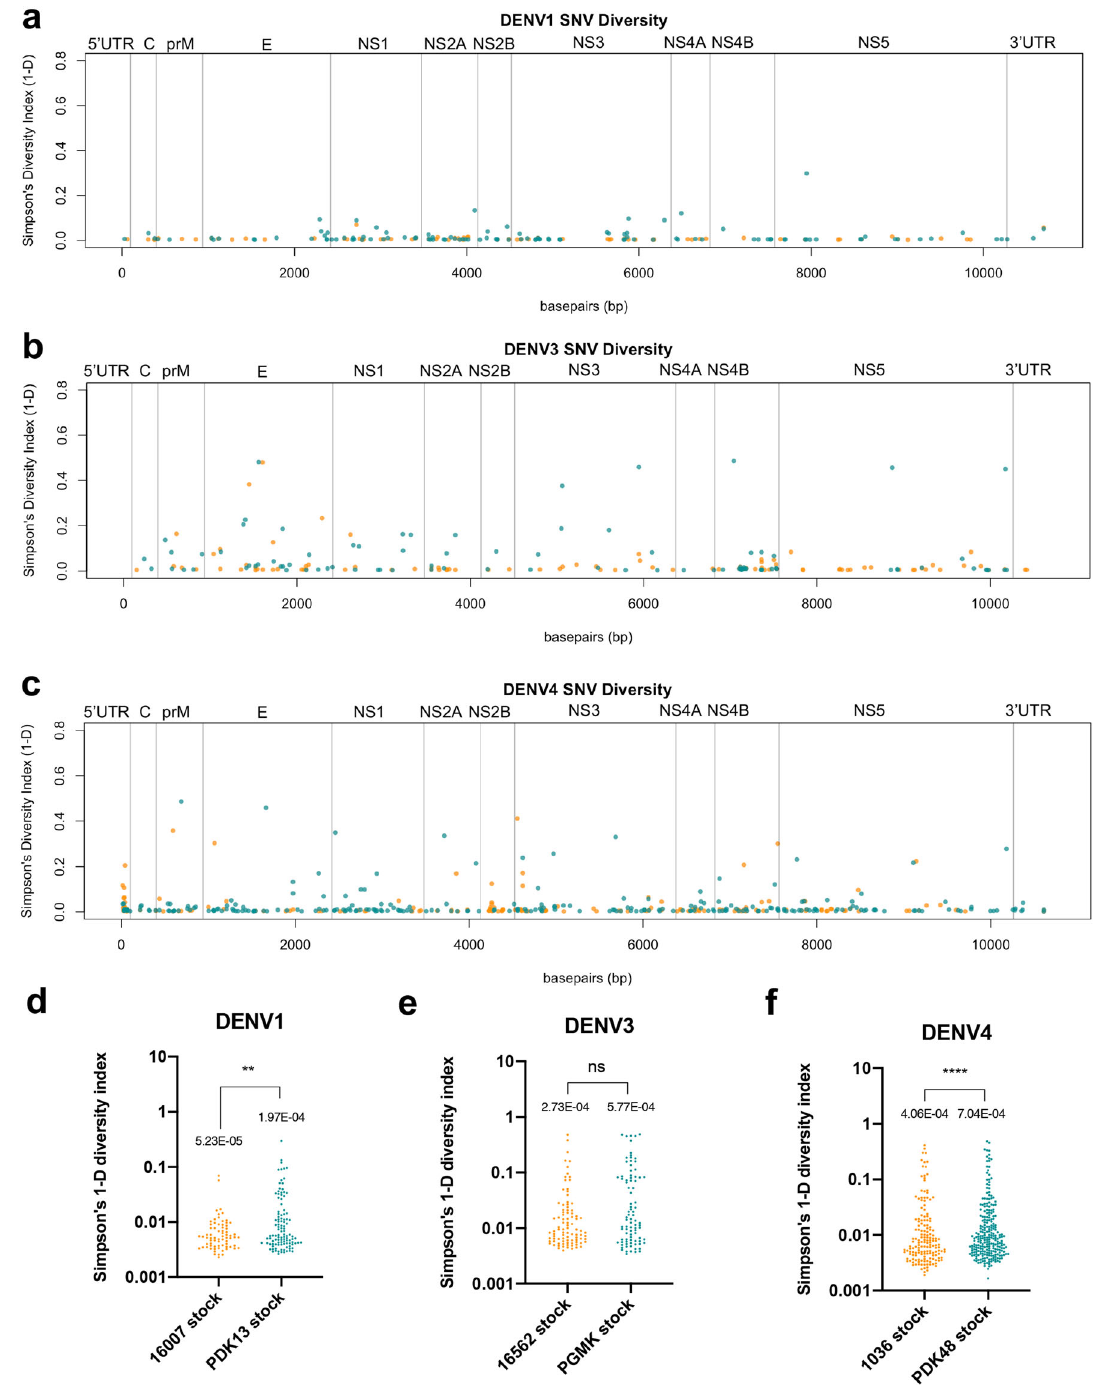
Fig. 3 DENV attenuated strains are genetically more diverse than their parent wild-type strains. Diversity of SNVs, measured by Simpson ’ s diversity index, identi fi ed in ( a ) DENV1 ( b ) DENV3, and ( c ) DENV4 wild-type isolate in orange and vaccine candidates in teal. The mean diversity of each SNV in ( d ) DENV1, ( e ) DENV3, and ( f ) DENV4 wild-type isolates (orange) and vaccine candidates (teal). Signi fi cance was analyzed by Mann – Whitney U